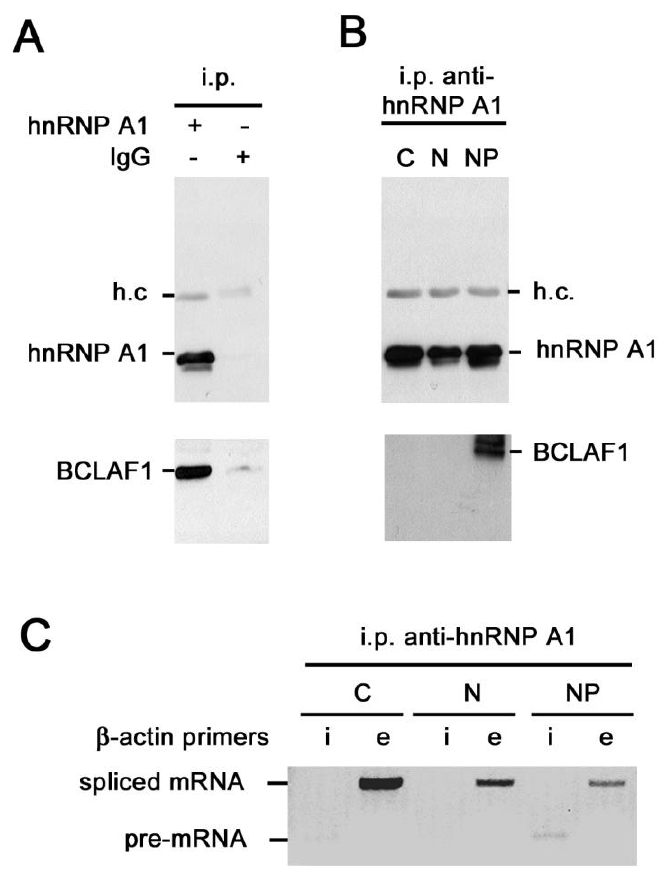
FIGURE 1. BCLAF1 associates with RNPs. (A) BCLAF1 coimmunoprecipitates with hnRNP A1. HeLa cell lysates subjected to immunoprecipitation with either anti-hnRNP A1 or control IgG (h.c. = heavy chain) were analyzed by Western analysis with anti-hnRNP A1 and anti-BCLAF1. (B) RNPs immunoprecipitated from cytoplasmic (C), nuclear soluble (N), and nuclear pellet (NP) fractions by anti-hnRNP A1 antibody (upper panel). BCLAF1 is contained with the fraction of RNPs in the nuclear pellet (NP, lower panel). (C) RT-PCR products of endogenous  -actin RNA from RNPs immunoprecipitated by anti-hnRNP A1 from fractions (C, N, and NP) validates that NP fractions of RNPs contain pre- mRNA (i) and spliced mRNAs